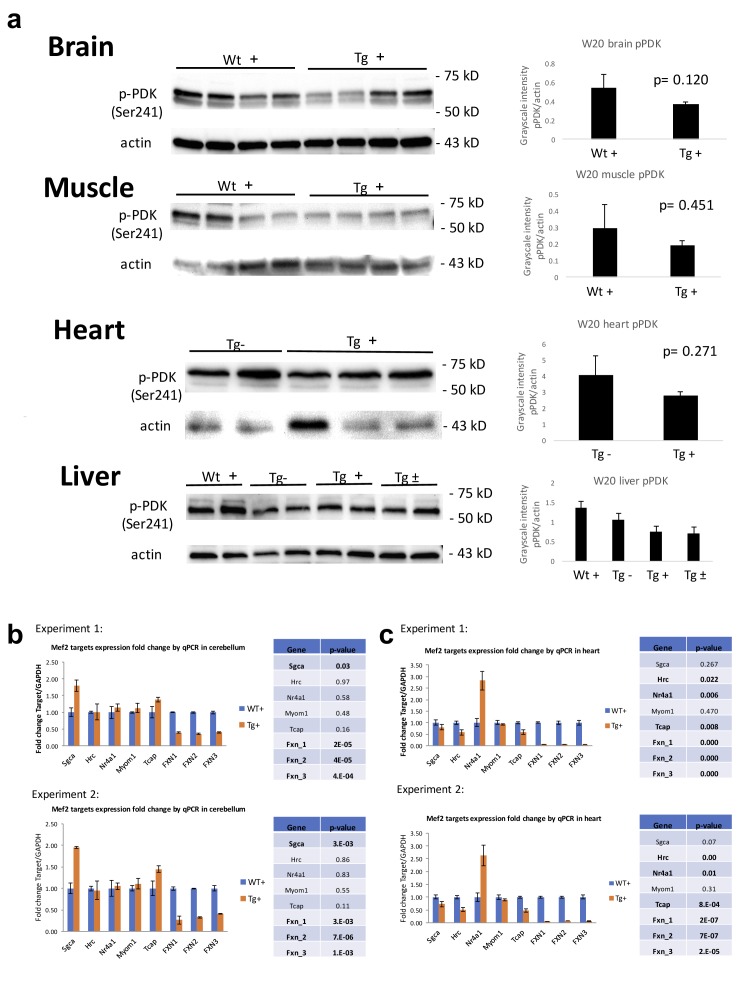
PDK1 and Mef3 pathway is not activated in Fxn knockdown mice.(a) Immunoblot and quantification of PDK1 phosphorylation levels in brain, muscle, heart and liver of dox treated wild-type (Wt +) and transgenic (Tg +) animals at week 20. (b) mRNA levels of Mef2 downstream targets in cerebellum and heart from 20 weeks post dox treated Wt + and Tg + animals. The results were obtained from two independent experiments utilizing four biological replicates. Error bars represent mean ±SEM.